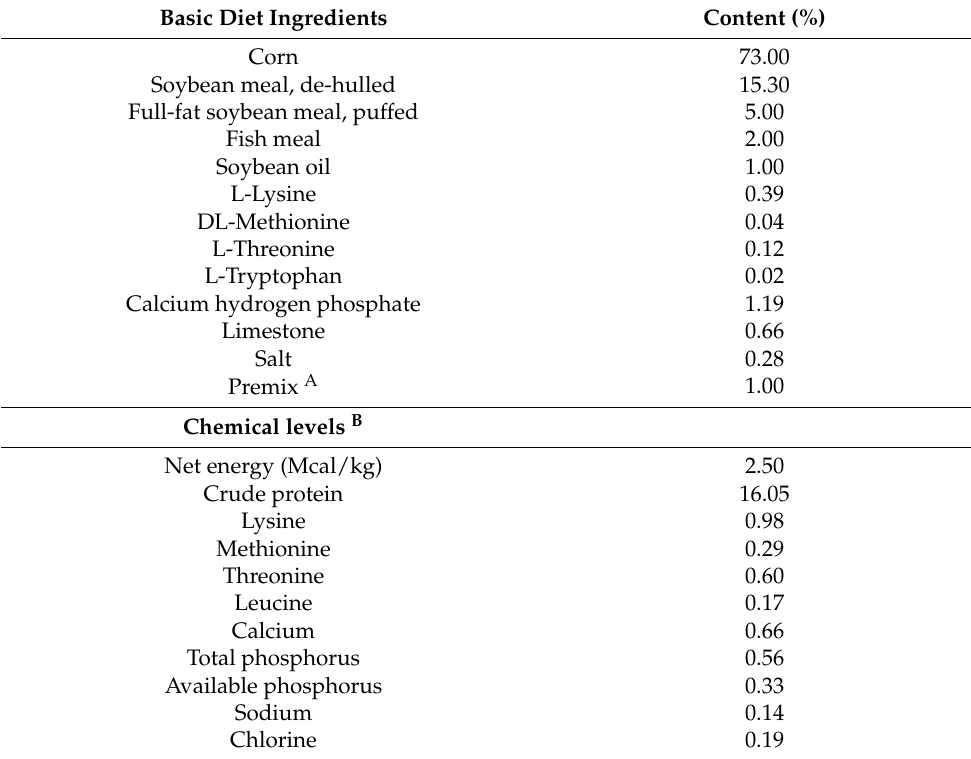
Table 1. Composition of experimental diets (90% of dry matter).